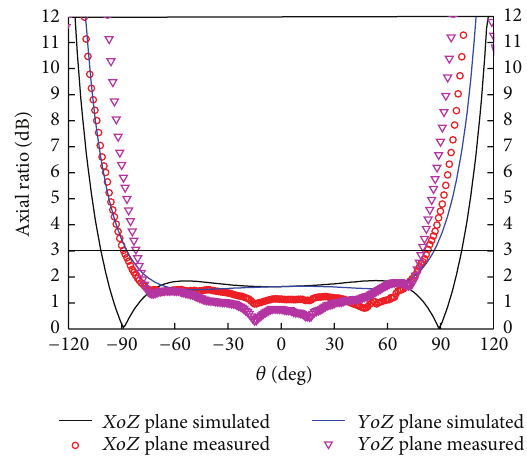
Figure 7: Measured and simulated reflection coefficient of the fab- ricated antenna.